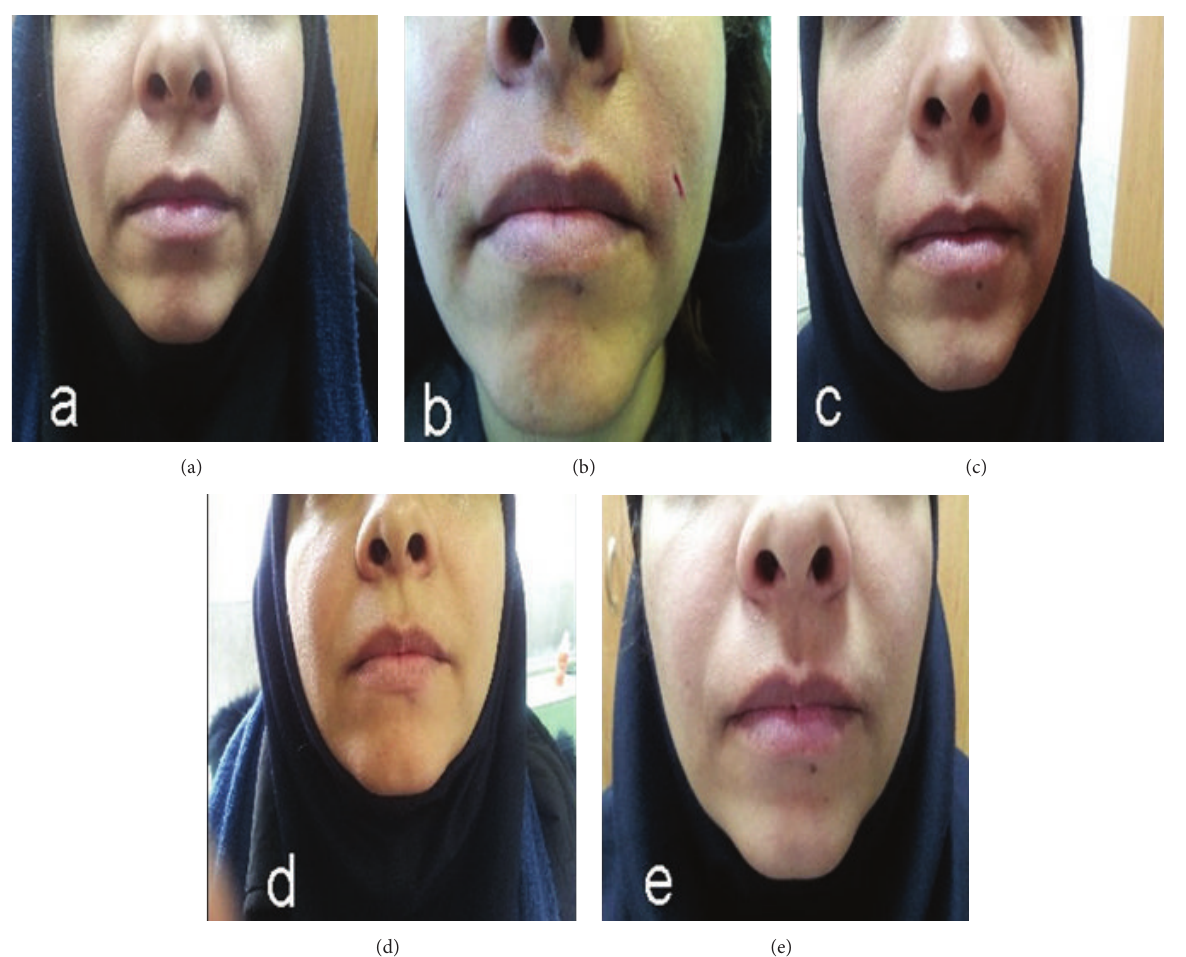
Figure 3: Marked improvement of nasolabial folds after subcision: (a) before and (b) immediately after treatment ( > 75% improvement), (c) one month (50–75% improvement) and (d) three months after subcision (25–50% improvement), and (e) six months after procedure ( ≈ 25% improvement). No depression at the needle insertion points was seen.